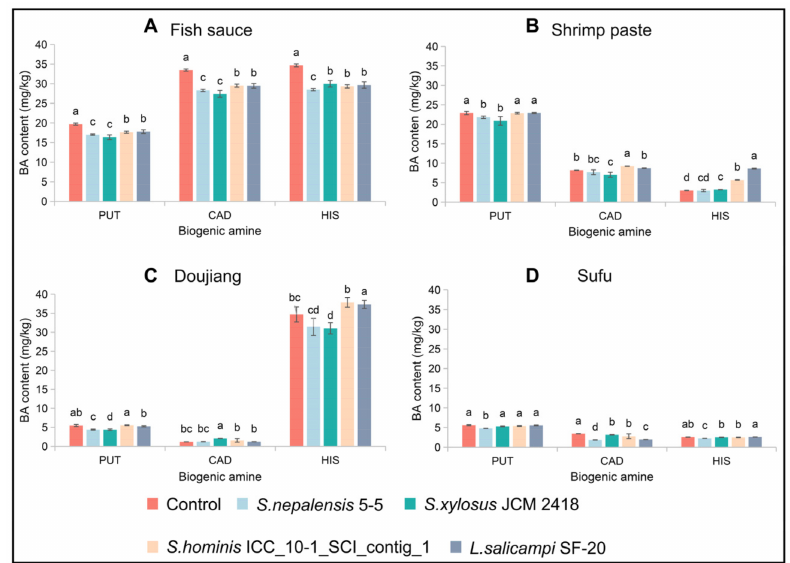
Figure 5. The content of BAs in fermented foods inoculated with different strains ( A : Fish sauce. B : Shrimp paste. C : Doujiang. D : Sufu.). Different letters (a, b, c, etc.) indicate the mean value of significant difference at p < 0.05. (PUT: Putrescine; CAD: Cadaverine; HIS: